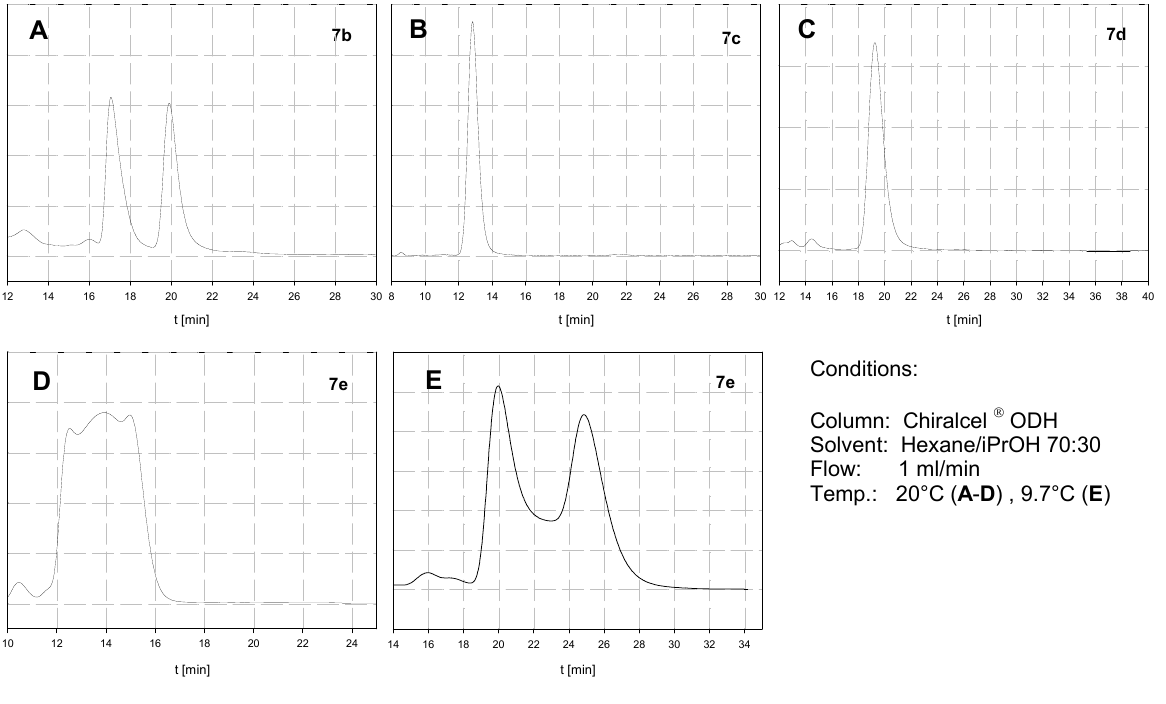
Figure 3. DNMR experiments of 7c (left) and 7d (right) in 1,1,2,2-tetrachloroethane-d 2